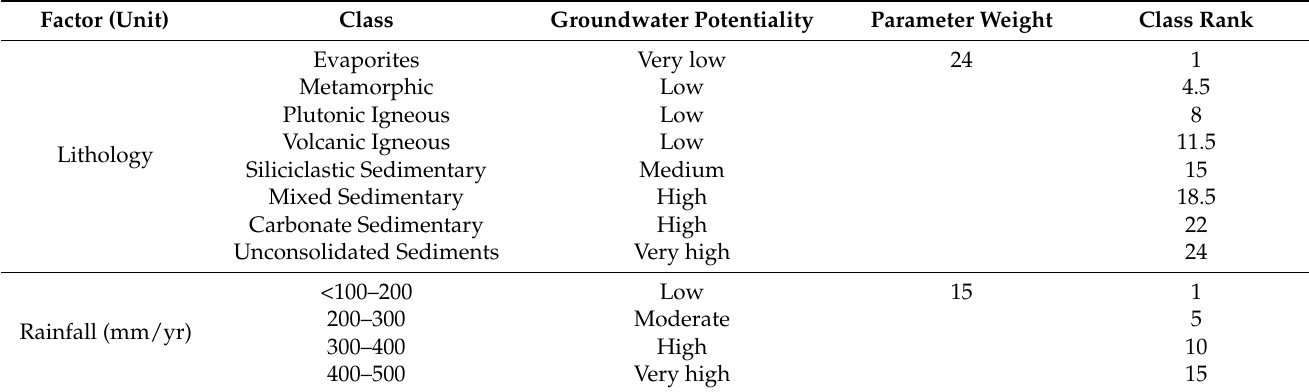
Table 7. Classification of parameters controlling the GWPZs in the Shatt Al-Arab